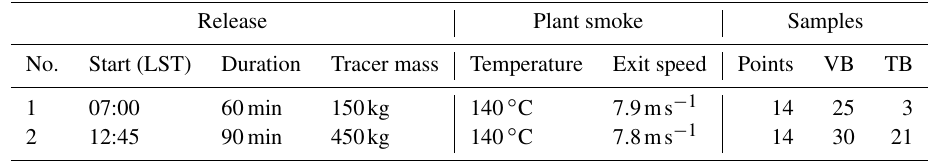
Table 3. Summary of the two releases performed during BTEX (VB: vacuum-filled glass bottles; TB: PVF bags).